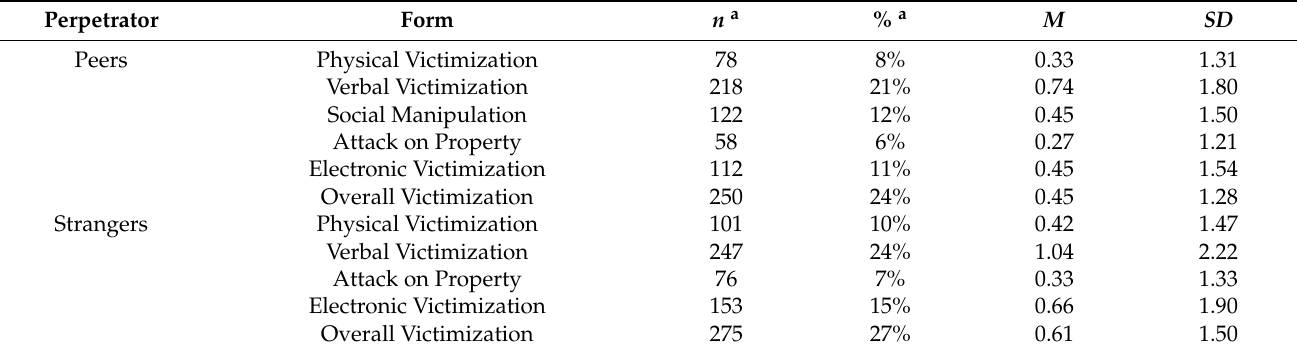
Table 2. Victimization Experiences Related to Political Disputes.